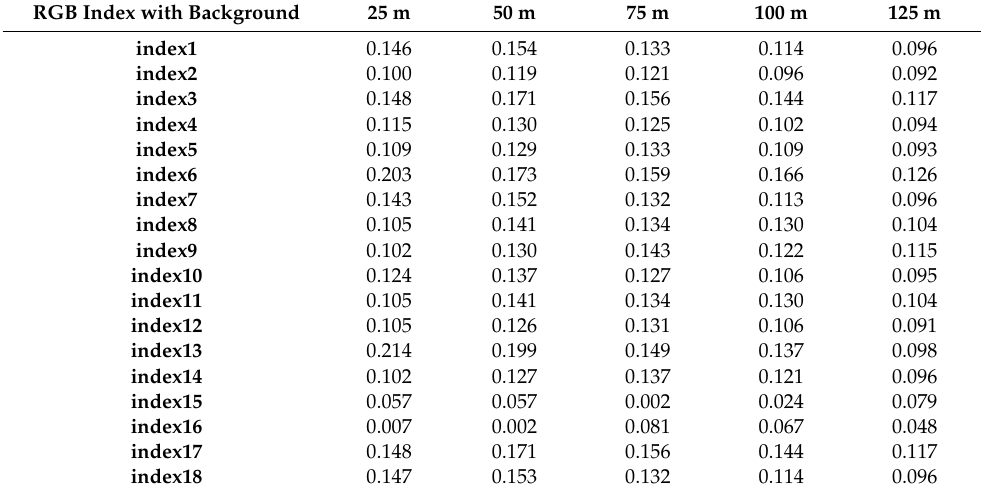
Table A2. The R 2 between vegetation indices calculated from RGB and chlorophyll contents using the images with background.